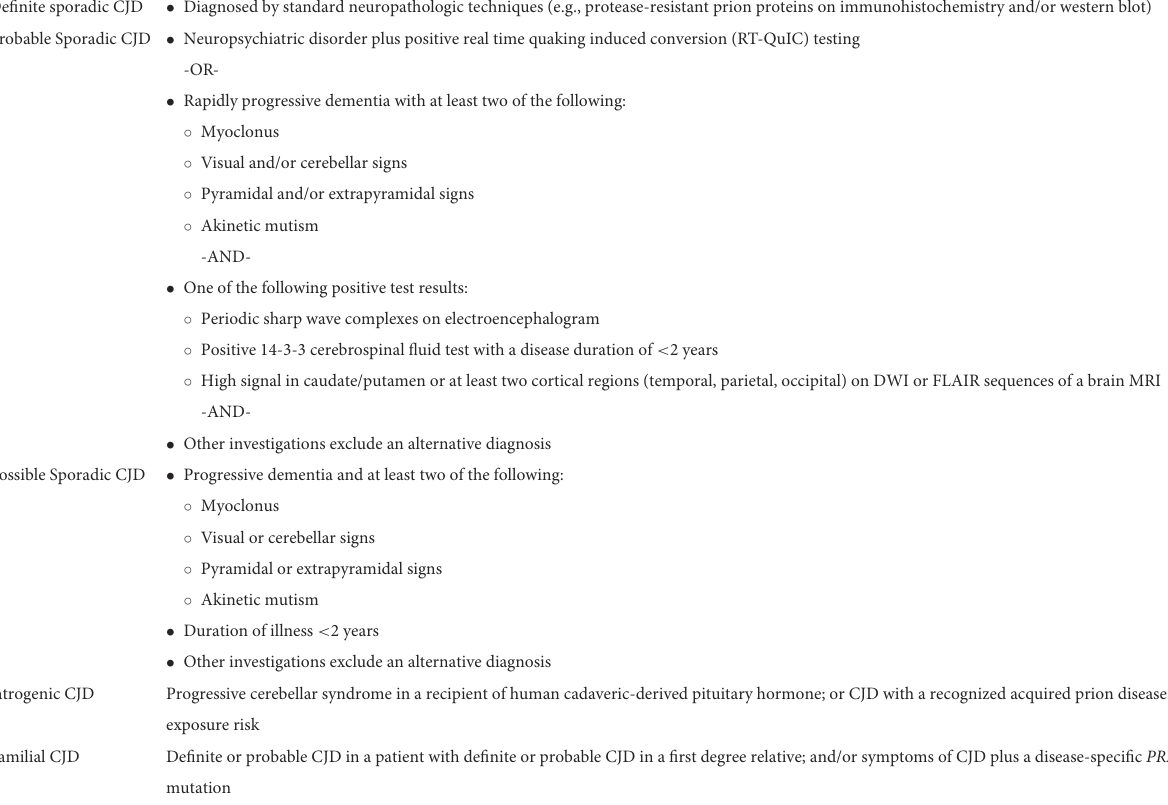
TABLE 1 Diagnostic criteria for Creutzfeldt-Jakob disease (CJD) (12). Definite sporadic CJD • Diagnosed by standard neuropathologic techniques (e.g., protease-resistant prion proteins on immunohistochemistry and/or western